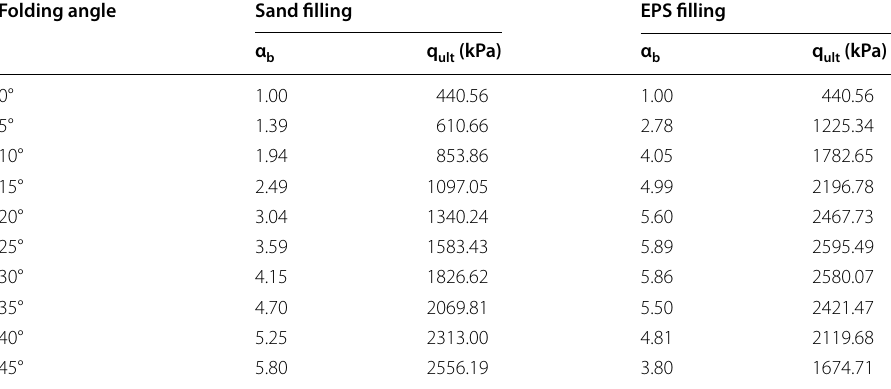
Table 2 Bearing capacity global modification factor for different folding angles Folding angle Sand